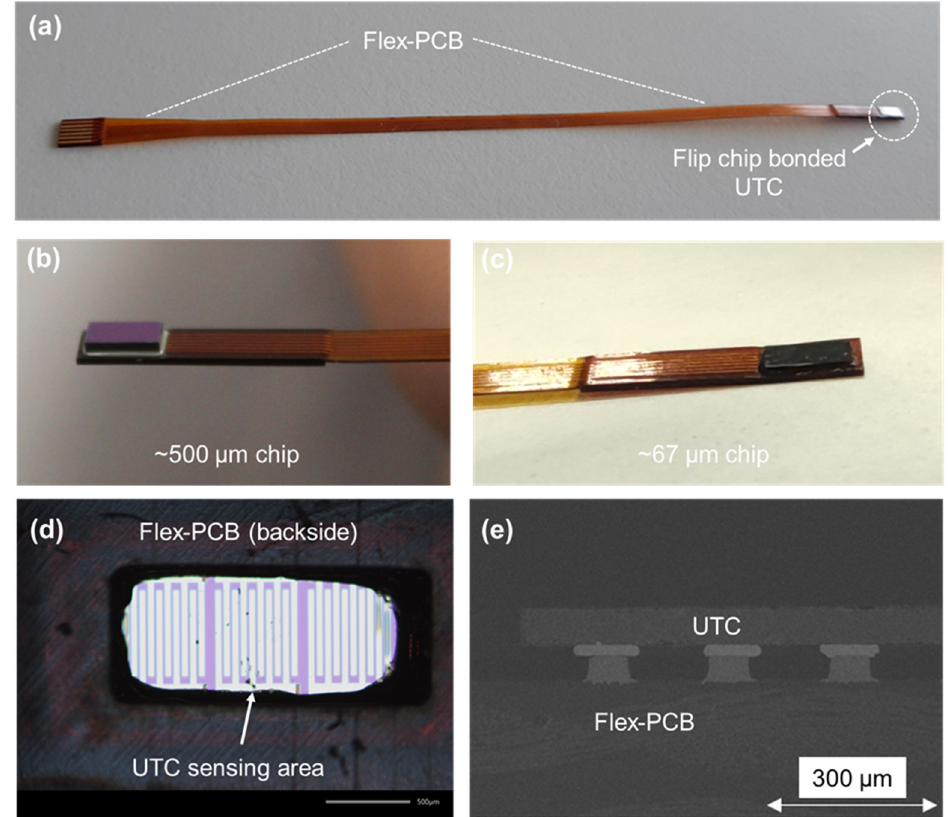
Figure 5. ( a ) Flip-chip integration of ultra-thinned chip (UTC) on flex with an exposed sensing area, ( b ) thick chip bonded on flex, ( c ) (UTC) bonded on flex, ( d ) exposed electrodes after bonding of UTC, and ( e ) SEM image of bonded UTC.